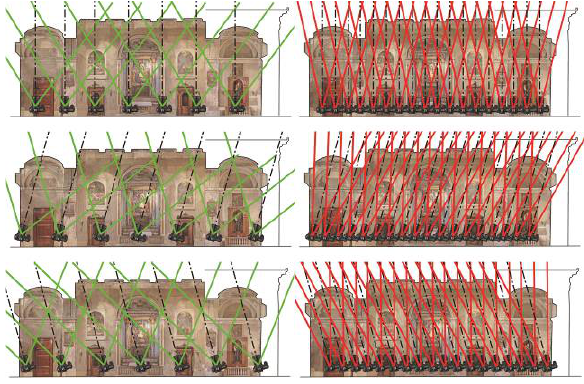
Figure 6. Camera axis direction, field of view and overlapping length in case of 24 mm lens (left) and 70 mm lens